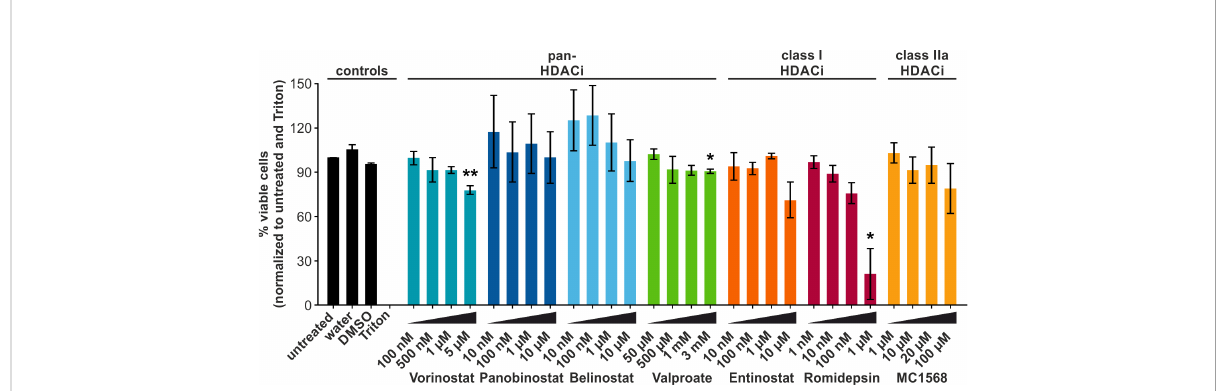
FIGURE 1 HDACi only mildly impair the viability of Jurkat T-cells. LDH release assays were performed in the Jurkat-U3R-Luc T-cells after 24 h of chemical treatment with pan-HDACi (Vorinostat, Panobinostat, Belinostat, Valproate), class I HDACi (Entinostat, Romidepsin), or class IIa HDACi (MC1568). Cells treated with Triton (dead cells) and untreated were set as 0% and 100 % viable cells, respectively. DMSO served as solvent control for all HDACi, except Valproate. Mean values of three independent experiments ± standard error (SE) are depicted and were compared using Student ’ s t-test (*, p < 0.05, or **, p < 0.01 relative to respective solvent